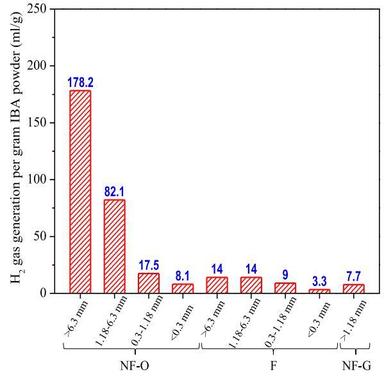
hows the volume of H2 gas generated per gram of classified IBA. Since aluminum is a non-ferrous metal, among the three IBA categories, NF-O showed a higher volume of H2 gas generated per gram of IBA, i.e., higher content of metallic aluminum. The amount of metallic aluminum also exhibited particle size dependency, specifically in the NF-O category. It was found that the metallic aluminum was mainly concentrated in NF-O (> 1.18 mm). The plausible reason behind the major concentration of metallic aluminum in